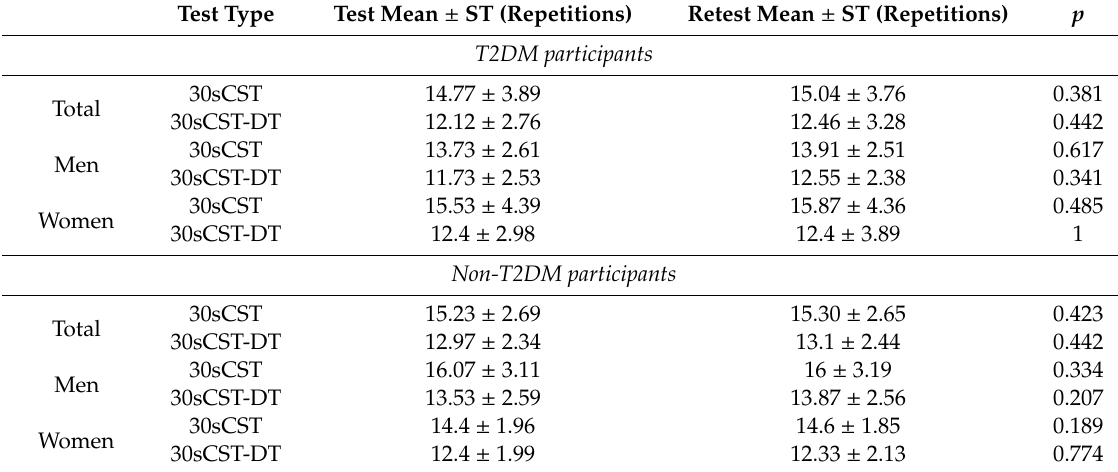
Table 2. Repetitions in the 30-s chair stand test and 30-s chair stand test with the dual-task test in two measurements (test–retest) taken 7–14 days